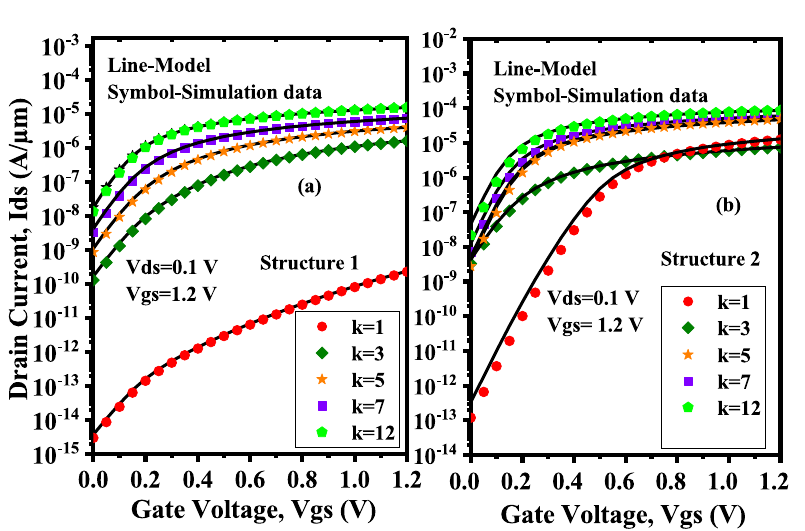
Figure 8. Variation in drain current w.r.t to gate bias for ( a ) Device structure-1 and ( b ) Device structure-2 ( V gs = 1.2 V , V ds = 0.1 V , dielectric constants, κ = 1, 3, 5, 7, 12 , N f = 0